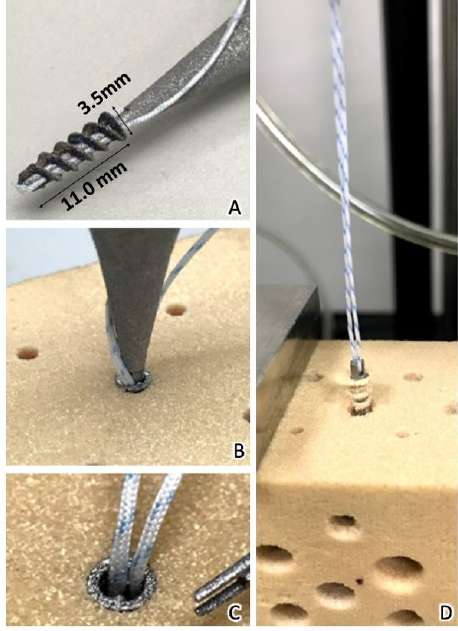
Figure 2. ( A ) The dimensions of the Fe SA were 11.0 × 3.5 mm. ( B ) An inserter handle was designed to hold the Fe SA, which was inserted into a predrilled hole on the polyurethane foam block. ( C ) After inserting the SA and removing the inserter handle, the suture exited the core of the iron SA. ( D ) The control group: the non-vented screw-type Ti SA had a tapered tip portion with sutures through the proximal eyelet. The suture was passed through the eyelet at the top of the SA. The Ti SA was pulled out of the polyurethane foam block during the mechanical test.